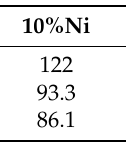
Table 1. BET surface area for the fresh and used methane catalysts reacted at 500 ◦ C and 700 ◦ C at Steam to Carbon Ratio S/C of